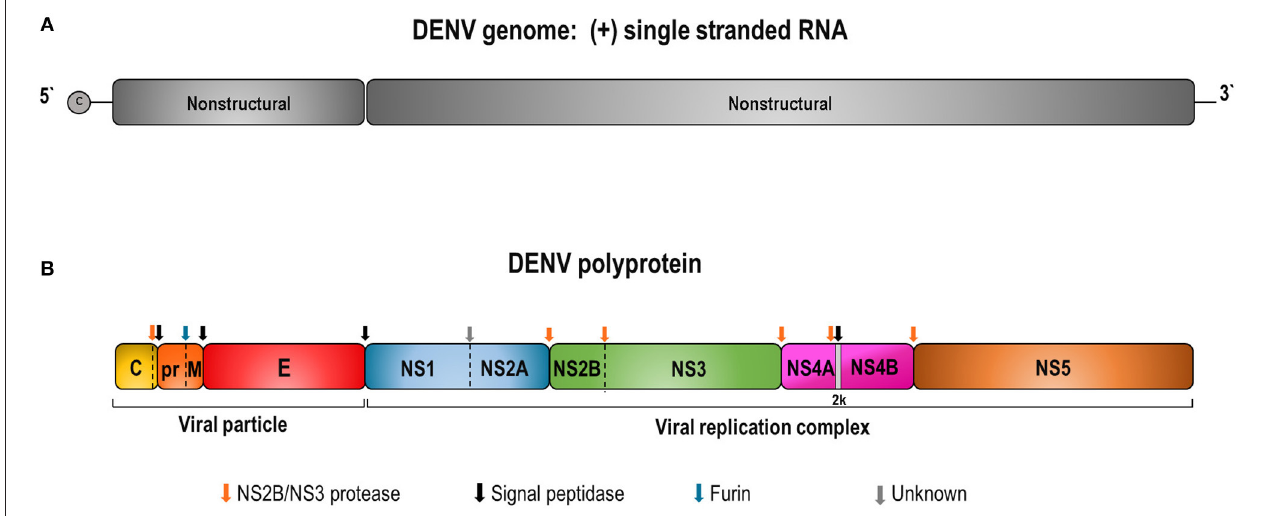
FIGURE 1 | Schematic representation of DENV genome (A) and the polyprotein precursor of viral proteins (B). (A) DENV contains a capped single-stranded and positive-sense RNA genome of about 10,700 bases in length. The DENV genome is an mRNA with one open reading frame encoding a single precursor polyprotein of about 3,400 amino acids. (B) The polyprotein cleavage by the viral NS2B/NS3 and host cell proteases generates 3 structural (C, prM/M, and E) and 7 non-structural (NS1, NS2A, NS2B, NS3, NS4A, NS4B, and NS5) proteins. Colored arrows indicate enzyme cleavage sites by the different